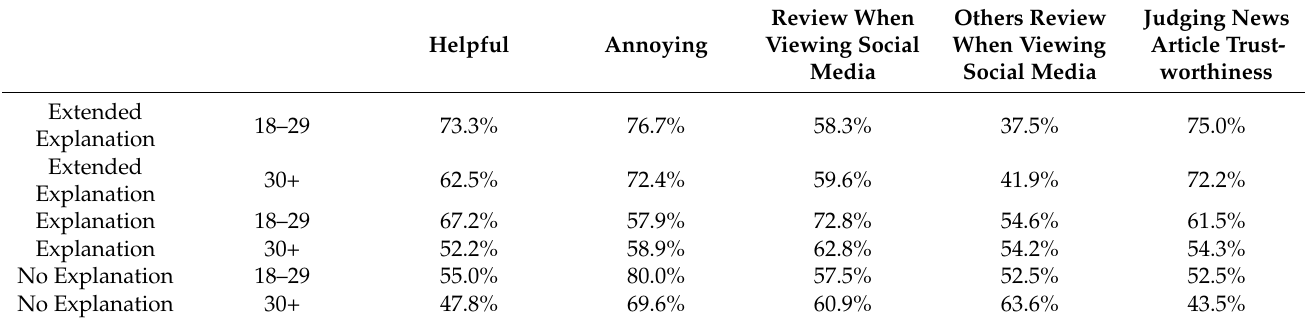
Table 25. Comparison of explanation versus no explanation by age group.